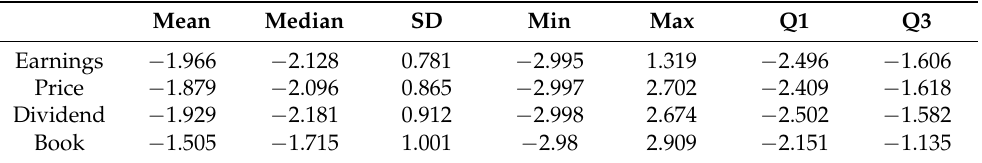
Table 2. Unit roots augmented Dickey–Fuller (ADF)